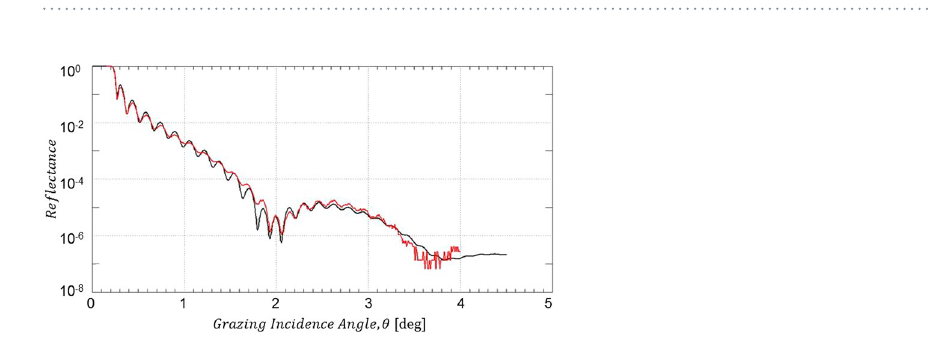
Figure 9. High-resolution C1s and B1s XPS spectra of the B 4 C-coated test wafer before (black solid lines) and after pure O 2 RF plasma cleaning (red solid lines). Left panel: XPS data taken on the amorphous carbon contamination spot. Right panel: XPS data taken off the amorphous carbon contamination spot on the bare B 4 C coating.